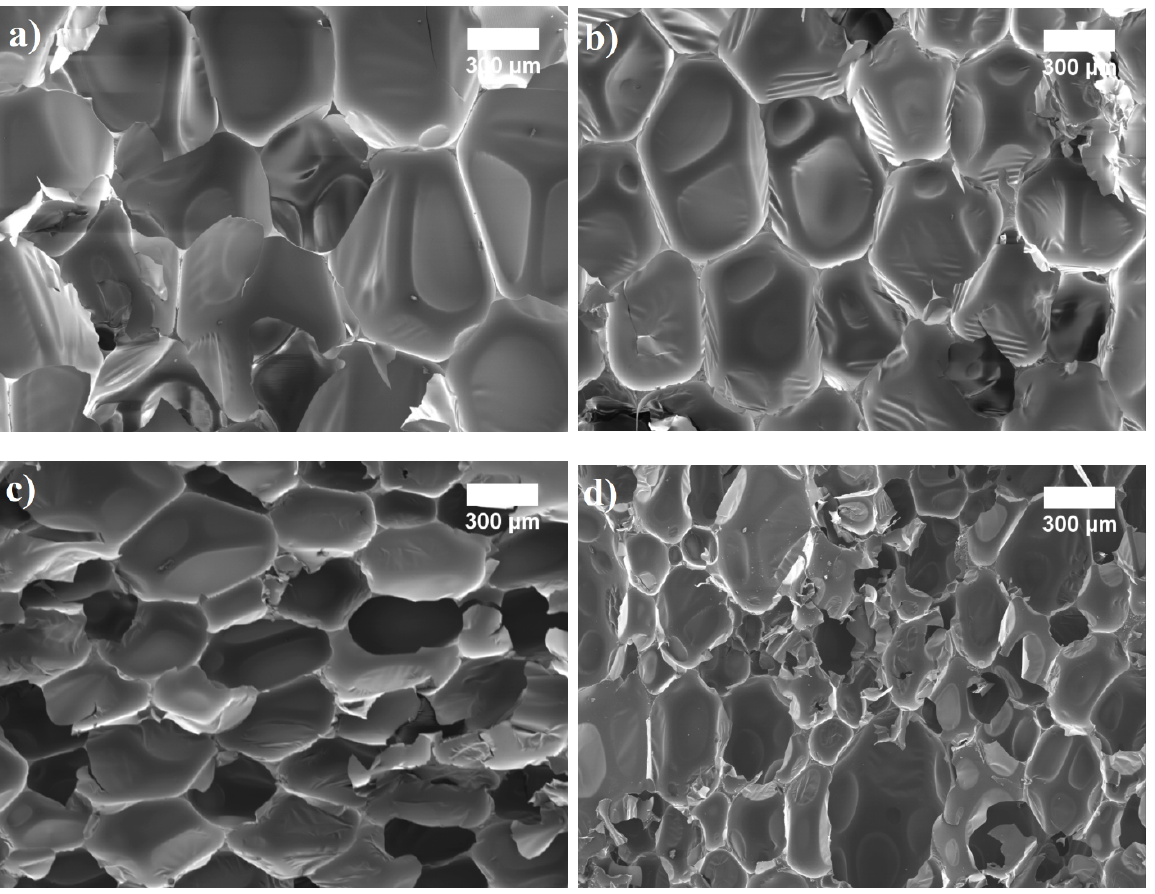
Figure 4. Microstructure of SFP filler modified PUR foams (×50 magnification): ( a ) at 0 wt.%; ( b ) 10 wt.%; ( c ) 20 wt.% and ( d ) 30 wt.%.